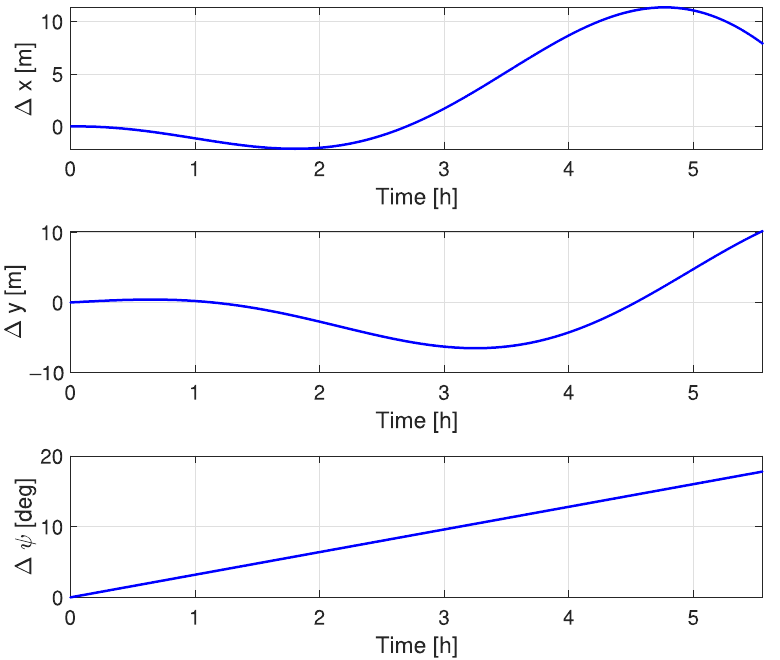
Figure 3. Integration errors in position ( ∆𝑥,∆𝑦) and orientation ( ∆𝜓) for the kinematic model.